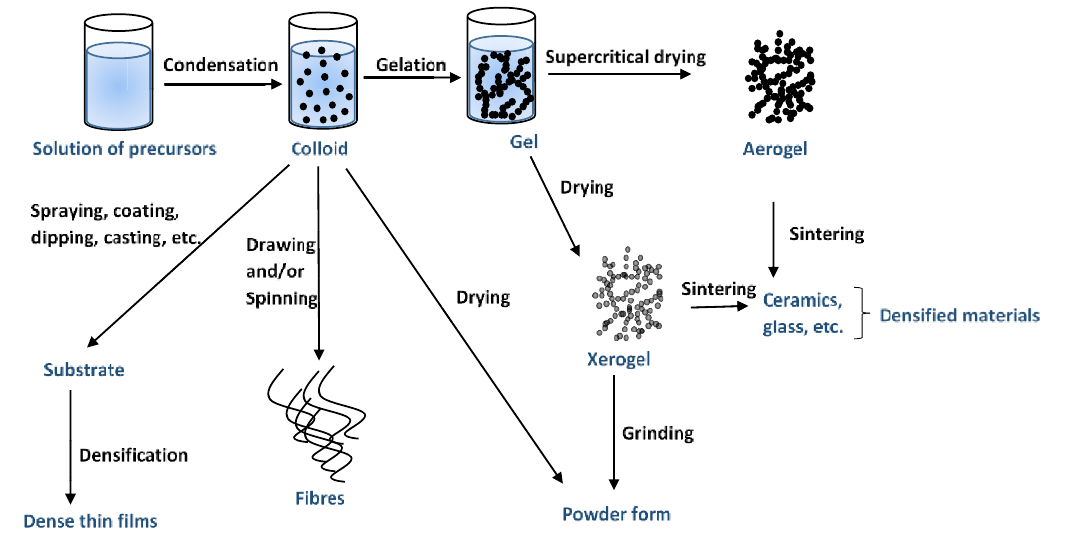
Figure 4: Simpli fi ed fl ow diagram of the sol – gel process used in the fabrication of nanocomposites. Adapted from ref. [ 99 ] , Copyright 2010, Springer -